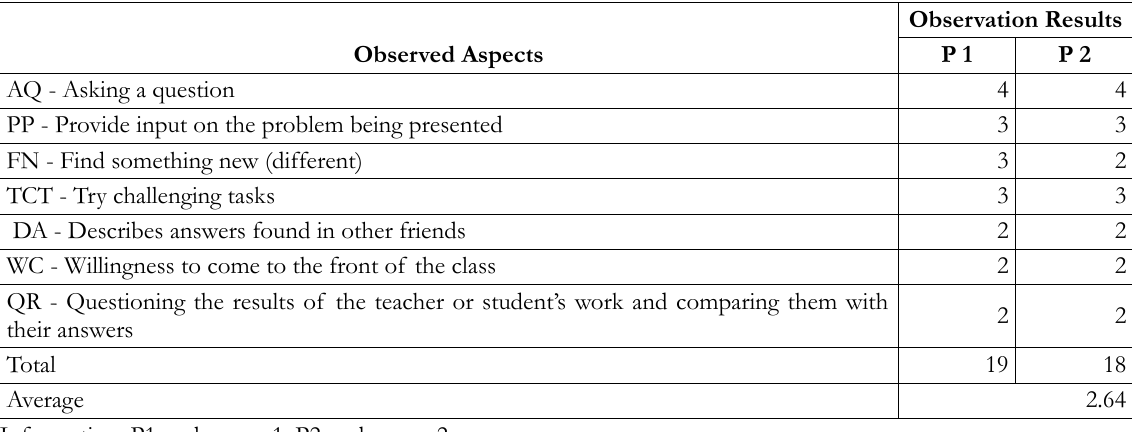
Table 2. The observation results of student